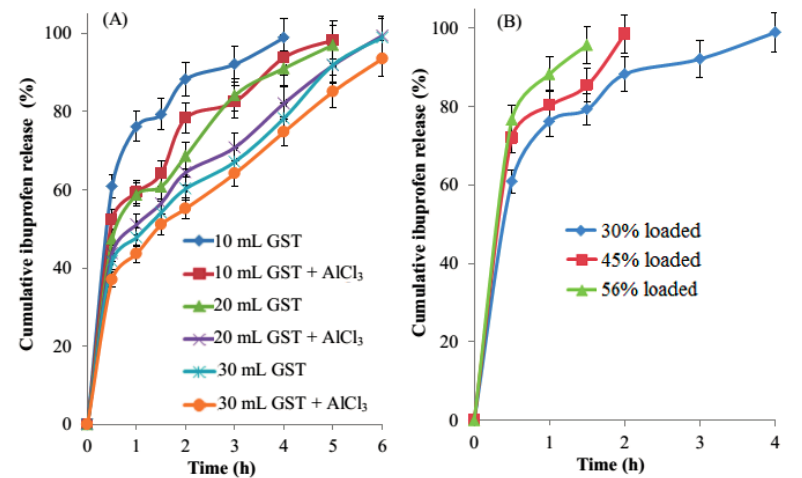
Figure 7. Influence of various cross-linking parameters ( A ) on the release profile of 30% m-INN loaded microcapsules, in which each point represents an average of three determinations; and the influence of m-INN loading on the release profile ( B ) of GST cross-linked microcapsules ( n =